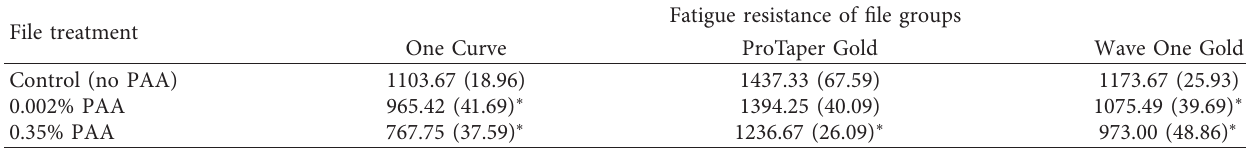
Table 2: The means and standard deviations (SD) of the number of cycles to failure of the tested files.